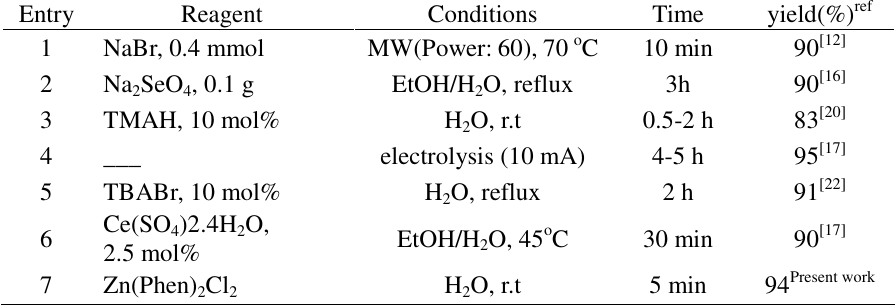
Table 3 . Synthesis of 2-amino-4-(4-chlorophenyl)-3-cyano-7,7-dimethyl-5-oxo-4 H -5,6,7,8- tetrahydrobenzopyran using different reagents and reaction